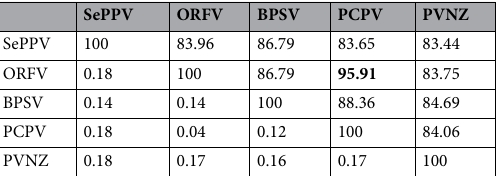
Table 4. Percentage amino acid identity between the DNA topoisomerase I within the genus parapoxvirus. Upper comparison gradient indicates percentage identity between two sequences; lower comparison gradient indicates the distance between two sequences as calculated by the distance measure Jukes-Cantor. Percentage identity higher than 90% is shown in bold